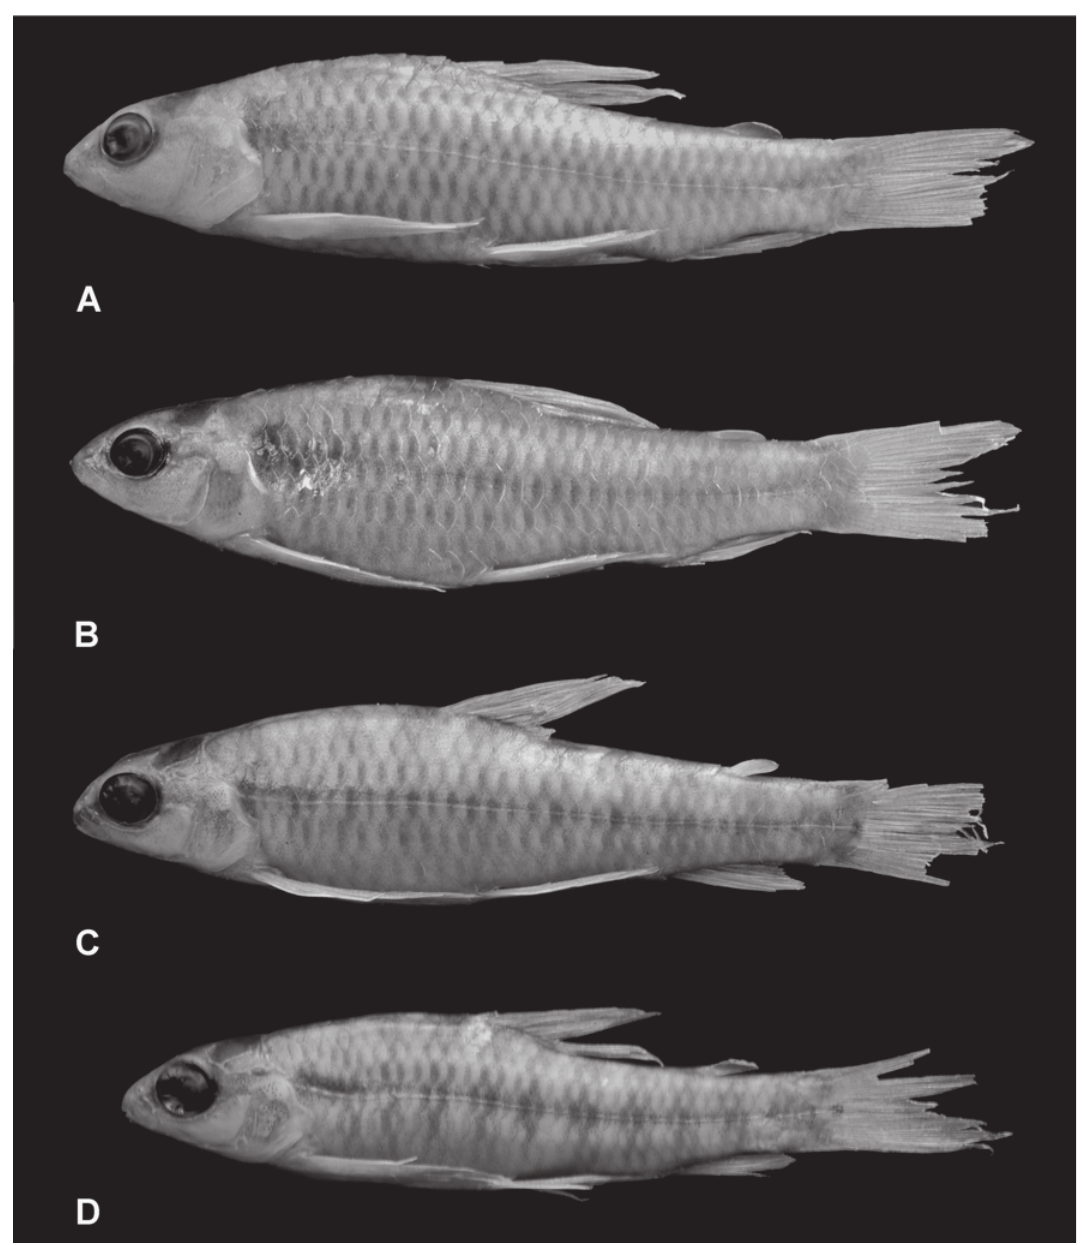
Fig. 2. Characidium xanthopterum , paratypes, MNRJ 11481, (A) 34.8 mm SL, (B) 32.1 mm SL, (C) 30.6 mm SL, and (D) 22.5 mm